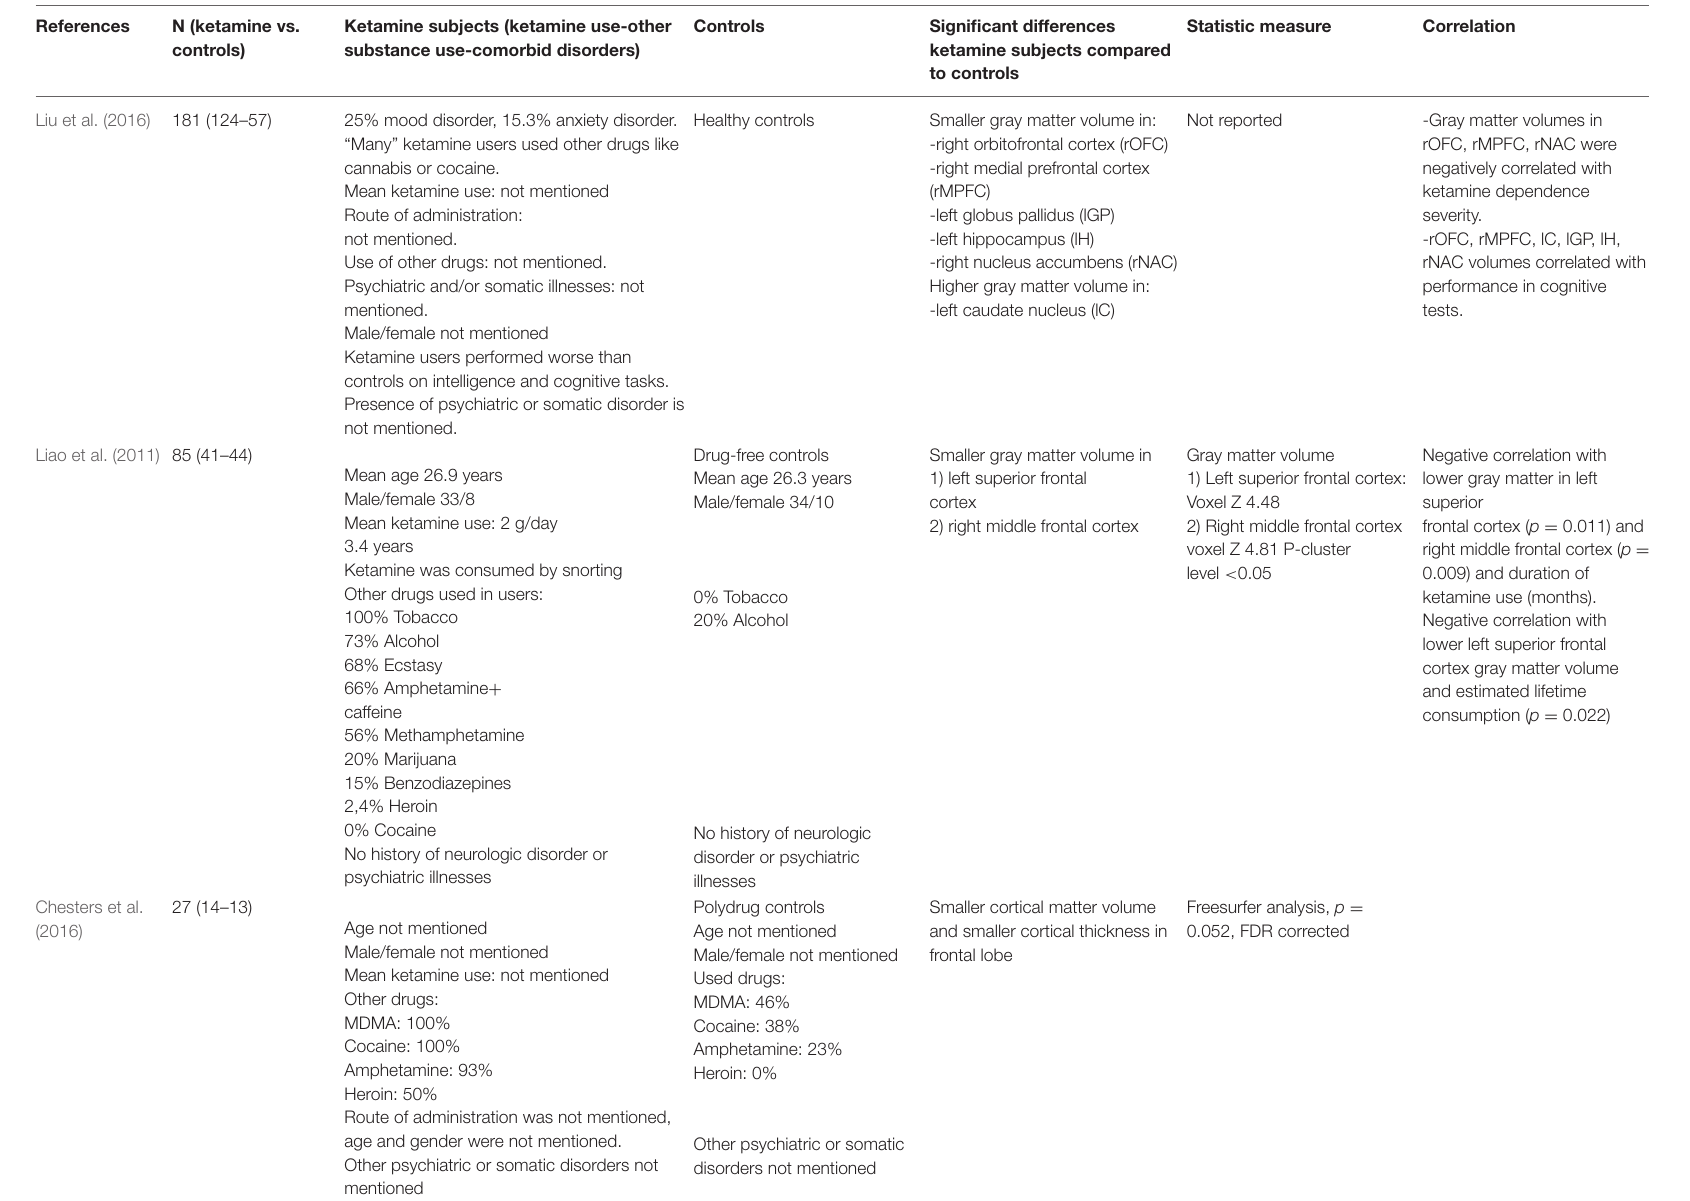
TABLE 1 | Structural differences: gray